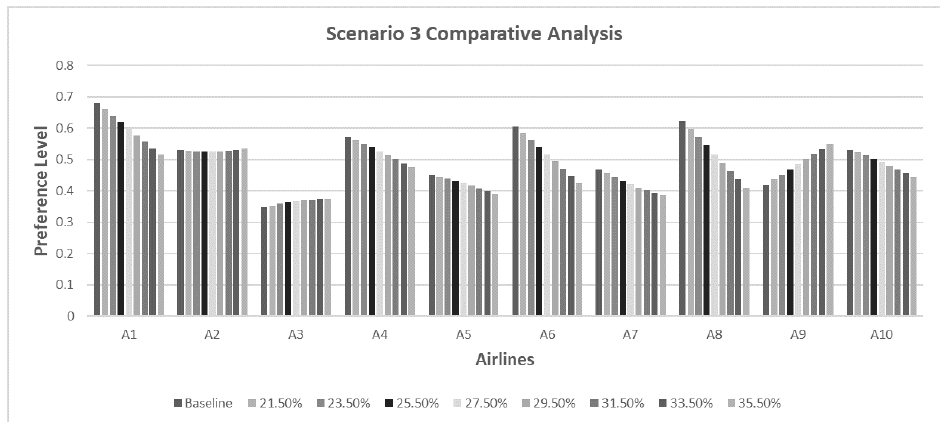
Fig. 6 . Comparison results of Scenario